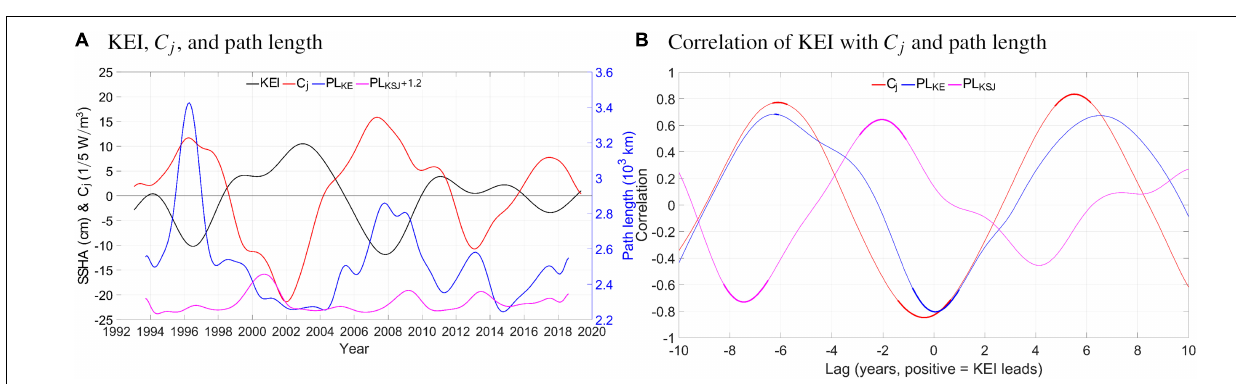
FIGURE 4 | (A) Time series of the KEI (black, left axis; cm), along-jet eddy-to-jet conversion rate C j averaged meridionally between 90 and 110 cm SSH contours between 142 and 160 ◦ E (red, left axis; 1/5 W/m 3 ), and path length of the KE (blue, right axis; 10 3 km) and KSJ (magenta, right axis; 10 3 km) defined as the 100 cm SSH contour between 142 and 165 ◦ E and 133 and 143 ◦ E, respectively. (B) Correlation between the KEI and the C j and path length indices in (A) . Thick curves denote statistical significance at the 95% level. The effective degrees of freedom are 2.9–4.6 ( C j ), 3.8–6.4 (PL KE ), and 6.5–10.8 (PL KSJ ) depending on the